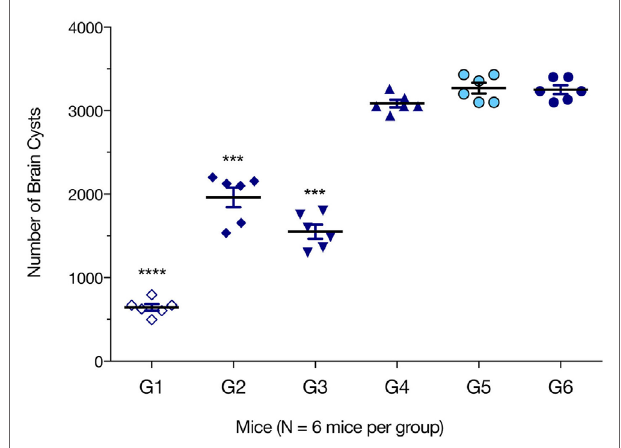
FigUre 6 | Protection against chronic toxoplasmosis in immunized mice 2 weeks after the final booster immunization. Six mice per group were challenged orally with a dose of 10 cysts of the Pru strain (type II). Cyst load was counted from whole brain homogenates of mice 6 weeks after challenge. Experimental groups include G1: mice received pVAX1 plasmids containing five antigens (ROP16, ROP18, MIC6, CDPK3, and PF); G2: mice received pVAX1 plasmids containing four antigens (ROP16, ROP18, MIC6, and CDPK3); G3: mice received pVAX1-PF; G4: mice received an empty pVAX1; G5: mice received phosphate-buffered saline alone; G6: healthy control mice. Data are mean ± SDs (representative of three experiments). *** p < 0.001 and **** p < 0.0001, compared with the control groups.